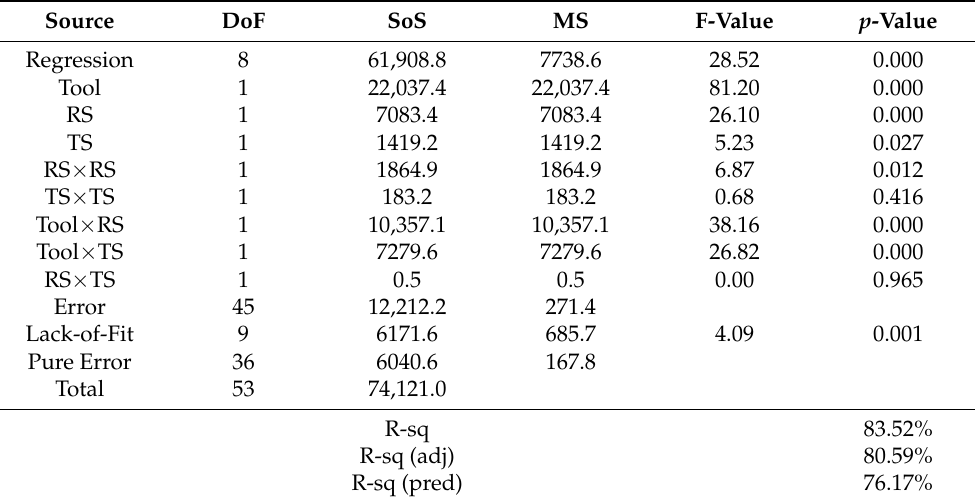
Table 3. Analysis of Variance—ANOVA: E versus Tool; RS; TS.